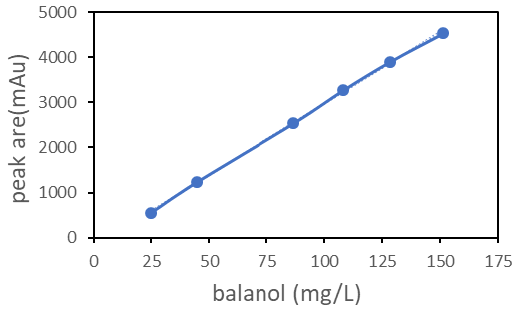
Figure 1. Standard curve of the balanol. Balanol was prepared in a solution from 25 mg/L to 180 mg/L for HPLC analysis. The peak area of balanol was used to establish the standard curve of its concentration. In the regression equation, Y = 31.764x − 203.51 (R 2 = 0.9993), Y indicates the concentration of balanol, and X indicates the peak area of balanol.